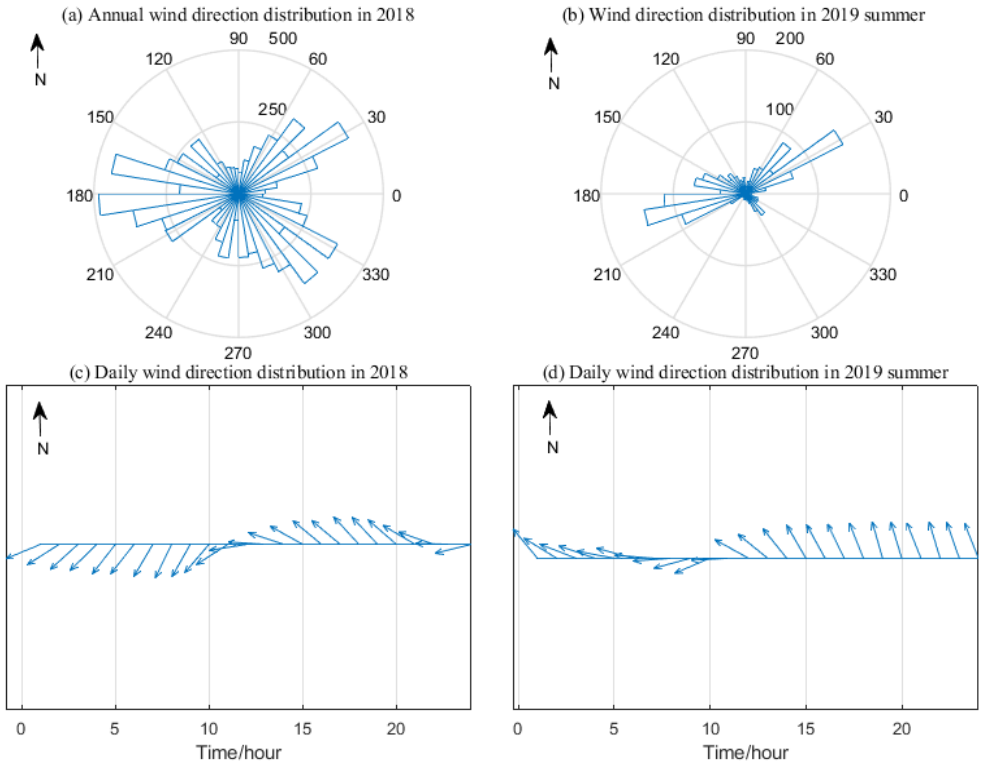
Figure 2. Wind direction distribution of the studied area in summer ( a ) 2018 and ( b ) 2019. Average daily wind direction distribution in summer ( c ) 2018 and ( d ) 2019.